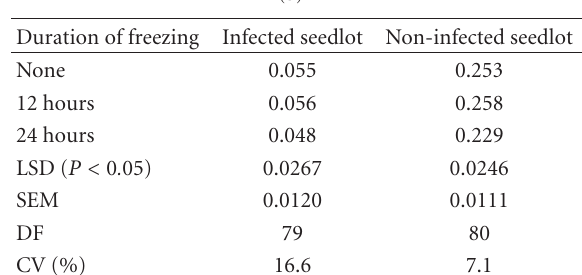
Data are back transformed, statistical analysis performed on square root transformed data. (b)